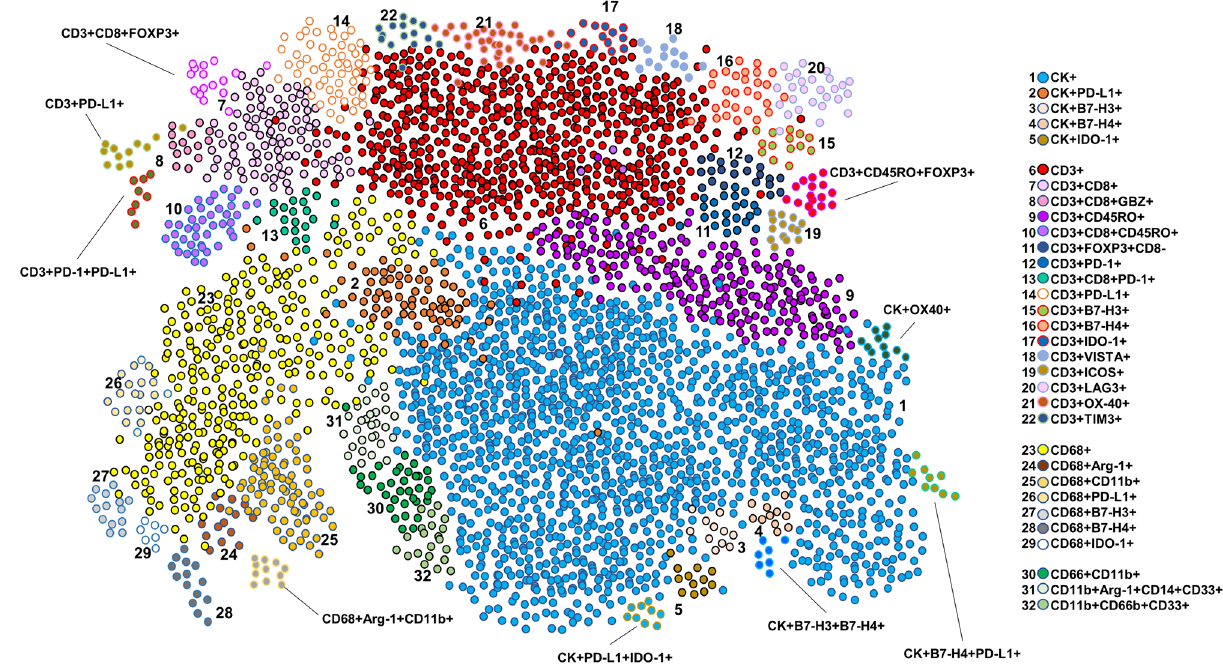
Figure 4. Graphic representation showing the clustering of different cells phenotypes obtained using the five multiplex immunofluorescence panels from a representative case of non-small cell lung cancer. On the right is displaying the list of expected cell phenotypes observed with those panels. Co-expression of different other cell phenotypes are also observed in clustering labeled by the co-expression of markers. The graphic was generated using R studio software version